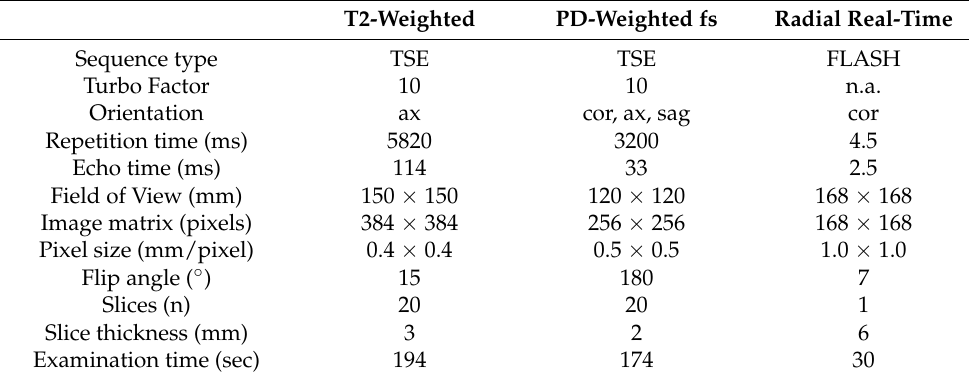
Table 1. Acquisition parameters of MR sequences. For the PD-weighted fat-saturated sequences, duration refers to the acquisition of a single orientation. Total measurement time for the acquisition of the three orientations was 8:42